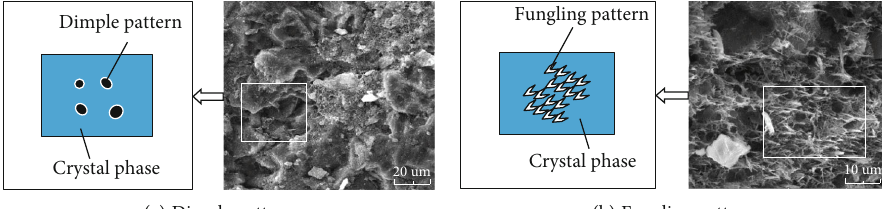
Figure 8: Ductile fracture morphology.